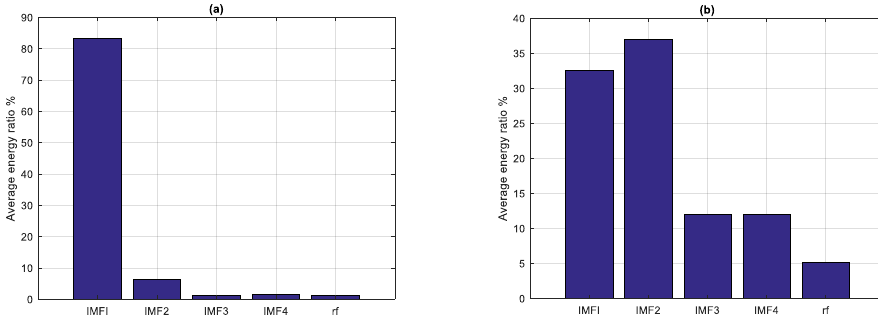
Figure 5. Average energy ratios of IMFs for ( a ) class I and ( b ) class II. (2) Marginal Frequency (MF)